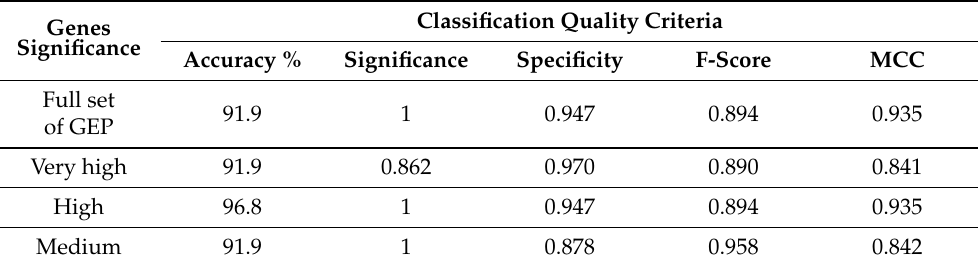
Table 2. Simulation results regarding the classification of objects based on gene expression data with various significance levels when applying the Harrington desirability